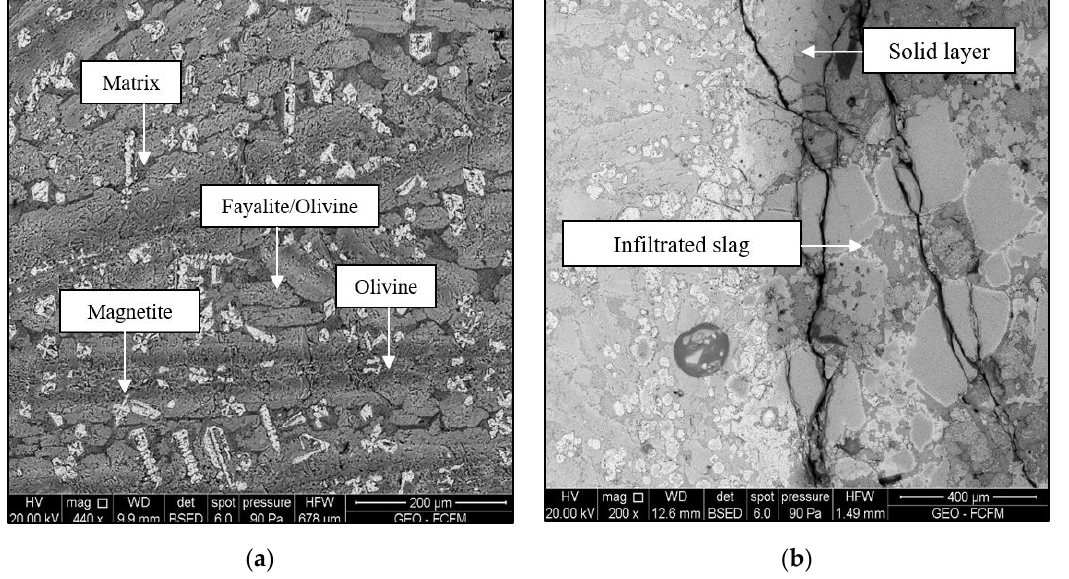
Figure 4. BSE image in SEM: ( a ) phases present in the final bulk slag; ( b ) phases present in the refractory brick hot face.